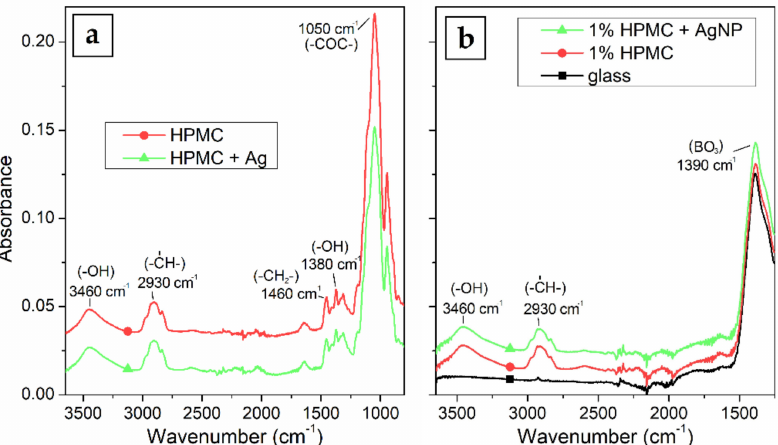
Figure 7. FTIR absorption spectra of ( a ) HPMC foil and HPMC–AgNP composite foil prepared from 1% HPMC solutions and ( b ) borosilicate glass substrate and thin films of HPMC and AgNPs prepared by